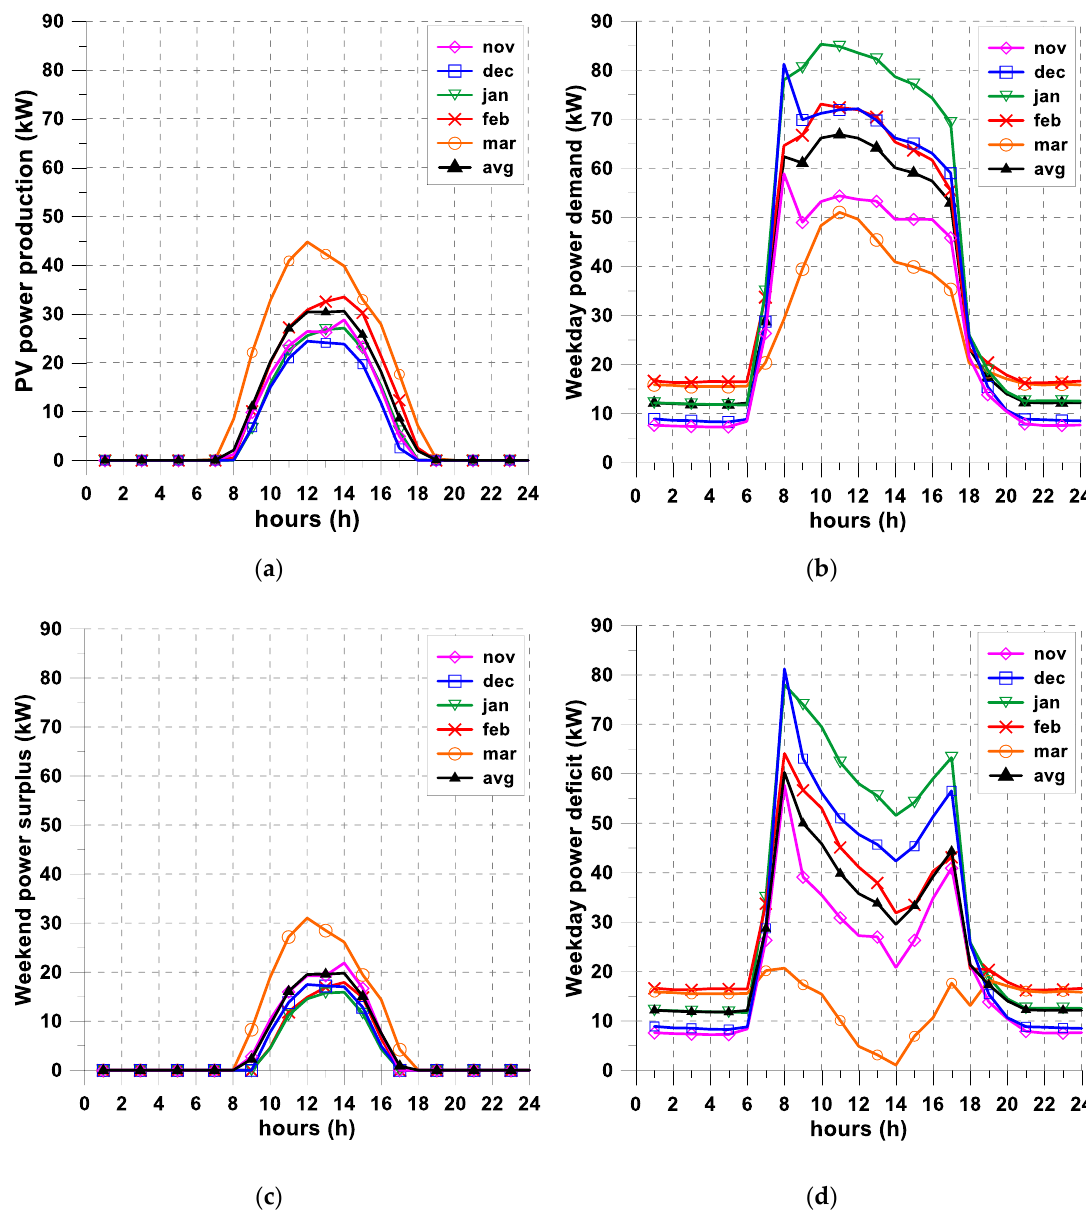
Figure 2. ( a ) Photovoltaic (PV) electricity production; ( b ) hourly electricity demand of a weekday; ( c ) daily surplus profile of a weekend day; ( d ) daily deficit profile of a weekday.